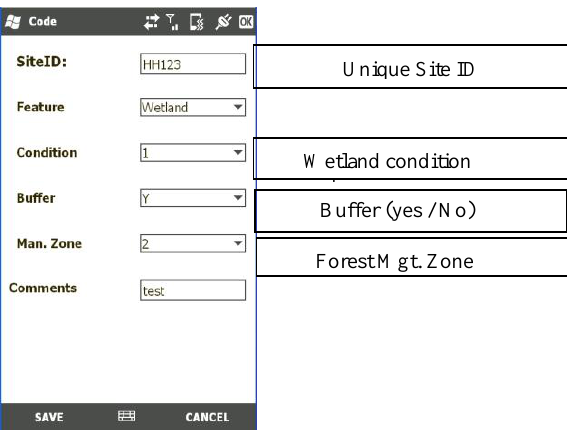
Figure 9. Template for coding attributes of